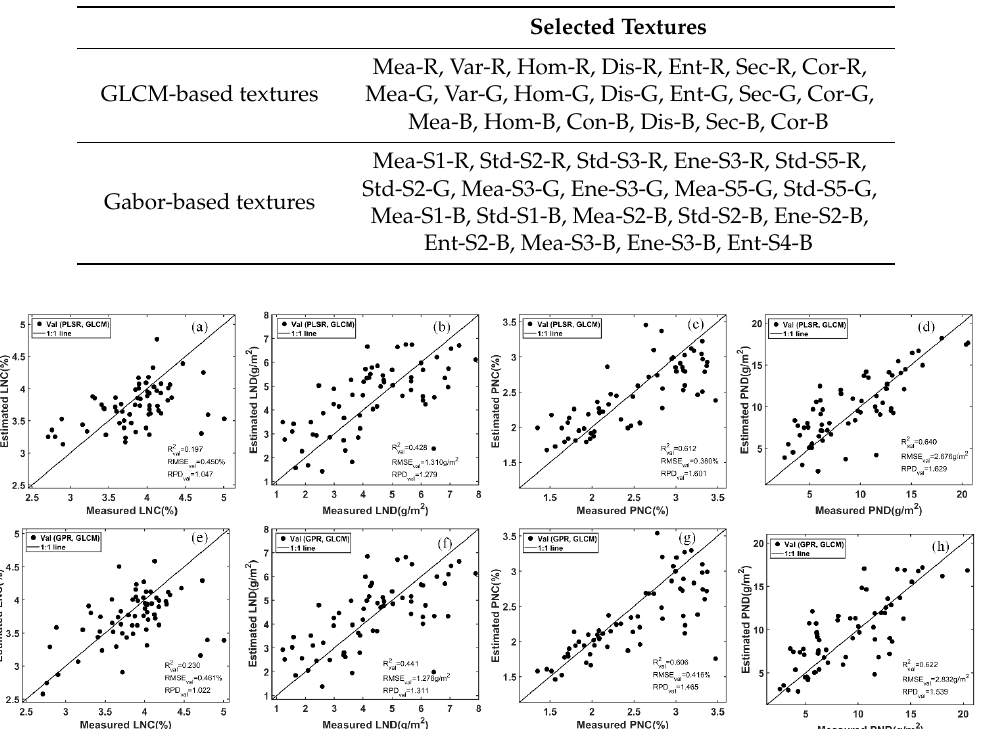
Figure 10. The predictive performance of ( a – d ) the PLSR and ( e – h ) GPR models based on the GLCM-based textures for winter wheat N status estimation.